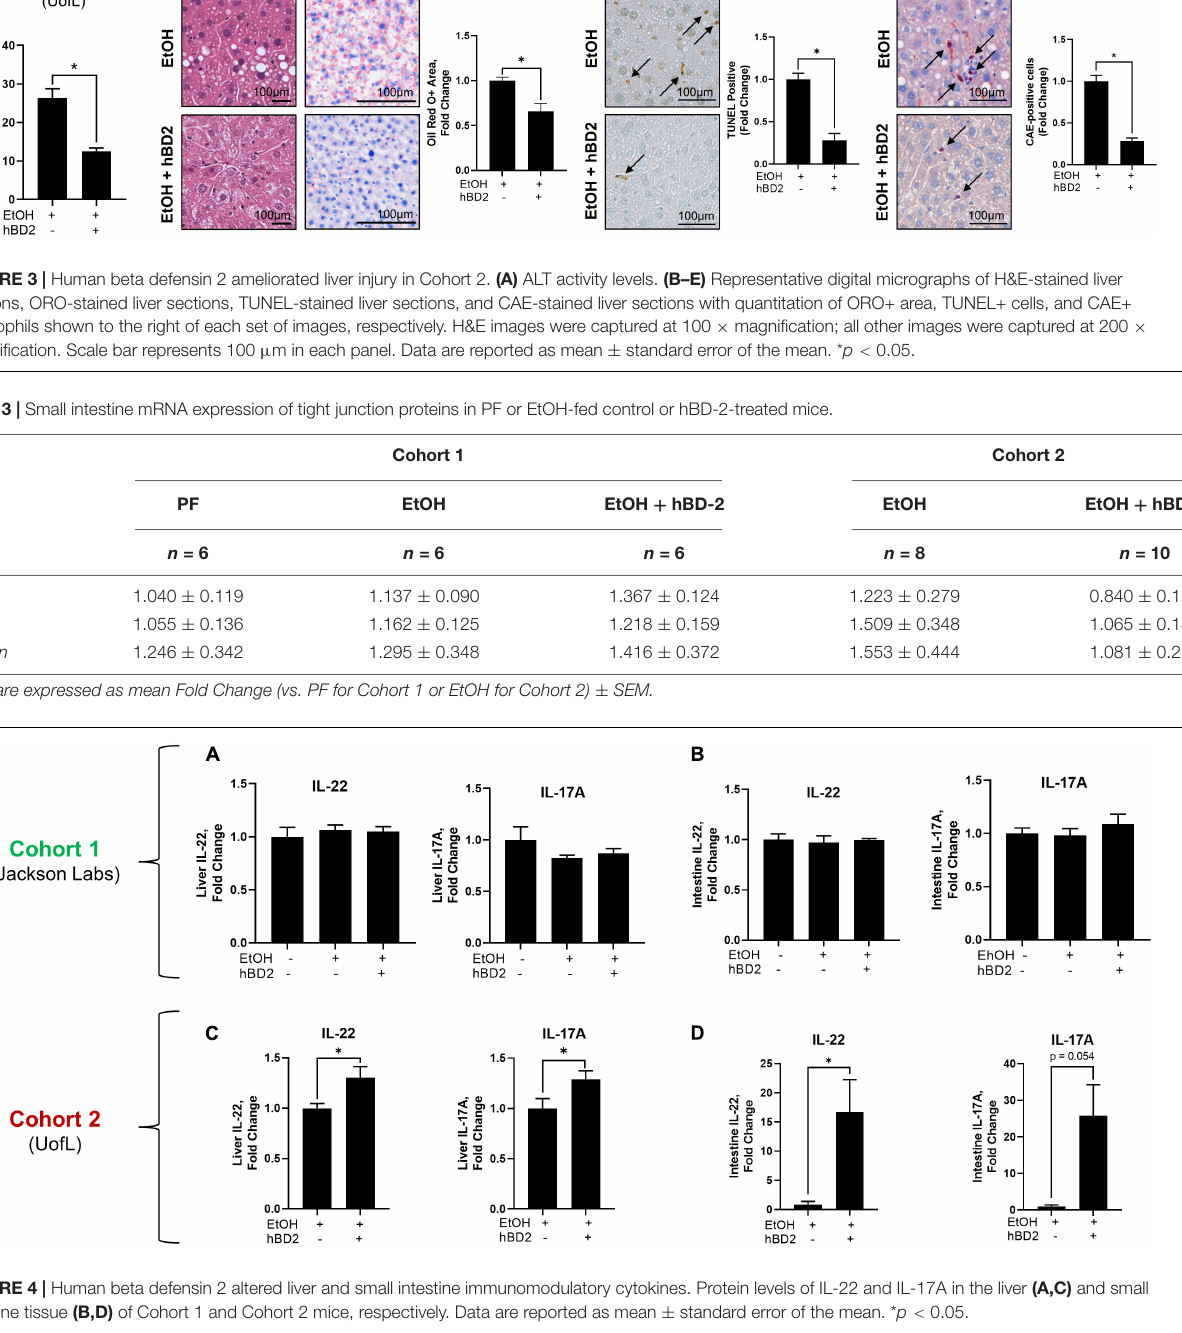
expression of other pro-inflammatory cytokines, including Cxcl1 , Mcp1 , and Mip2a in both cohorts ( Table 4